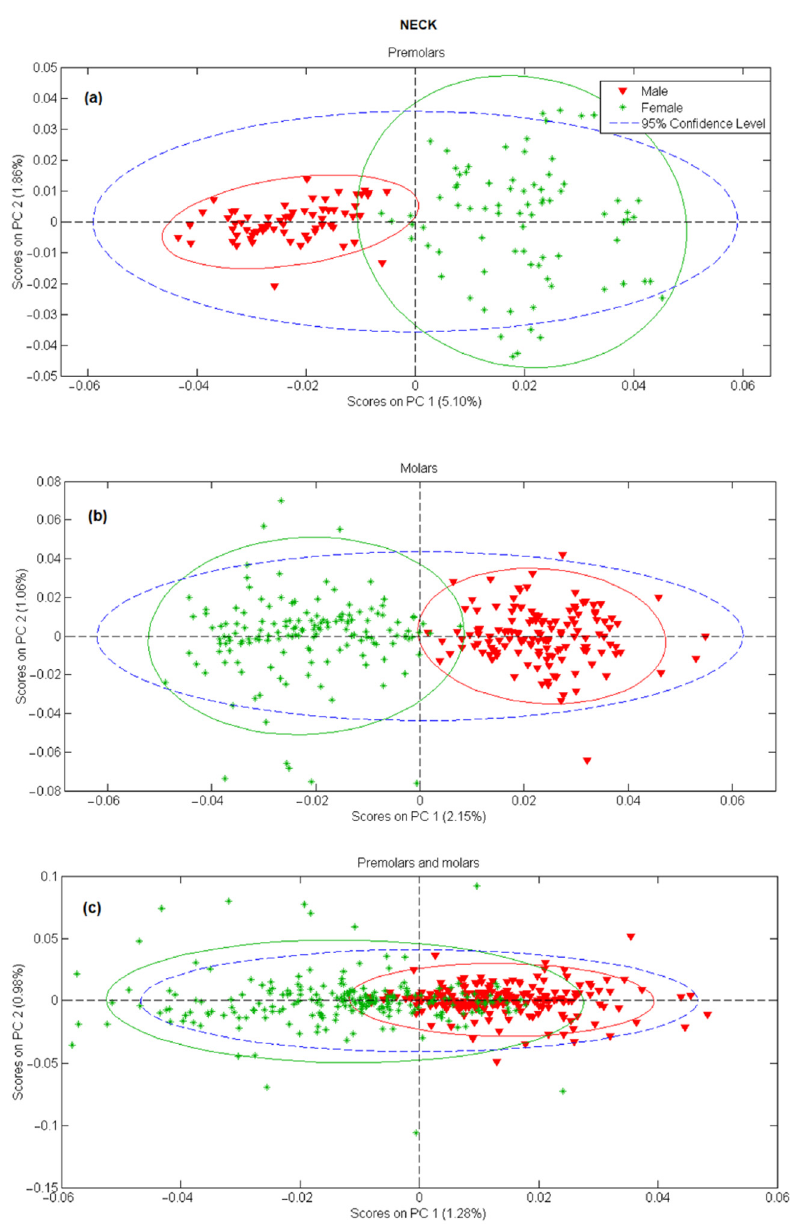
Figure 3. PC1 versus PC2 score plot resulting from the decomposition of Raman data obtained on tooth anatomical neck in the 3500–200 cm − 1 range for: ( a ) premolars, ( b ) molars, ( c ) premolars and molars.